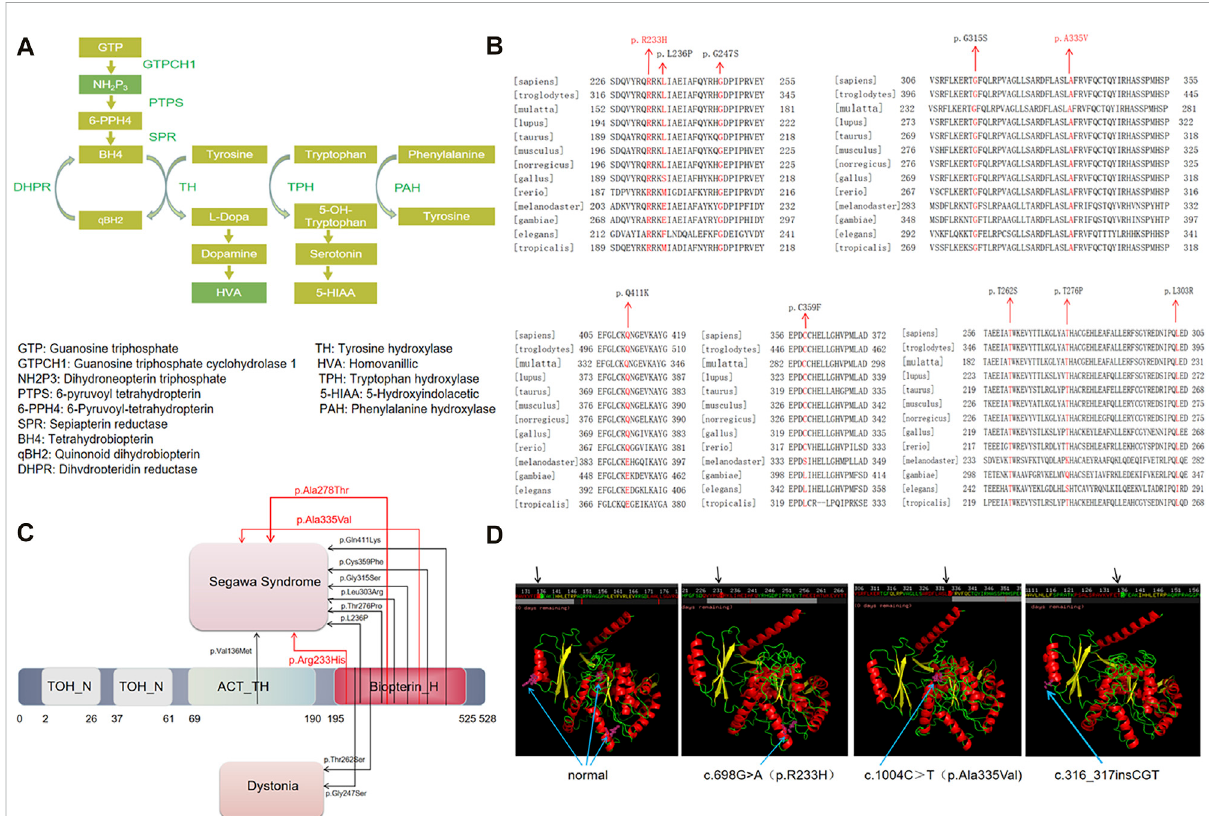
FIGURE 1 (A) Themetabolicprocessesoftyrosinehydroxylase,tryptophanandphenylalanineclarifythepathogenesisofDRDandTHD. (B) Thesequence of proteins corresponding to missense mutation sites in different species. (C) TH missense mutation spectrum. Variant listed as red font was discovered in this report. (D) The three-dimensional atomic models based on TH protein sequence from wild type and mutation sites generated by iterative threading assembly re fifi nement